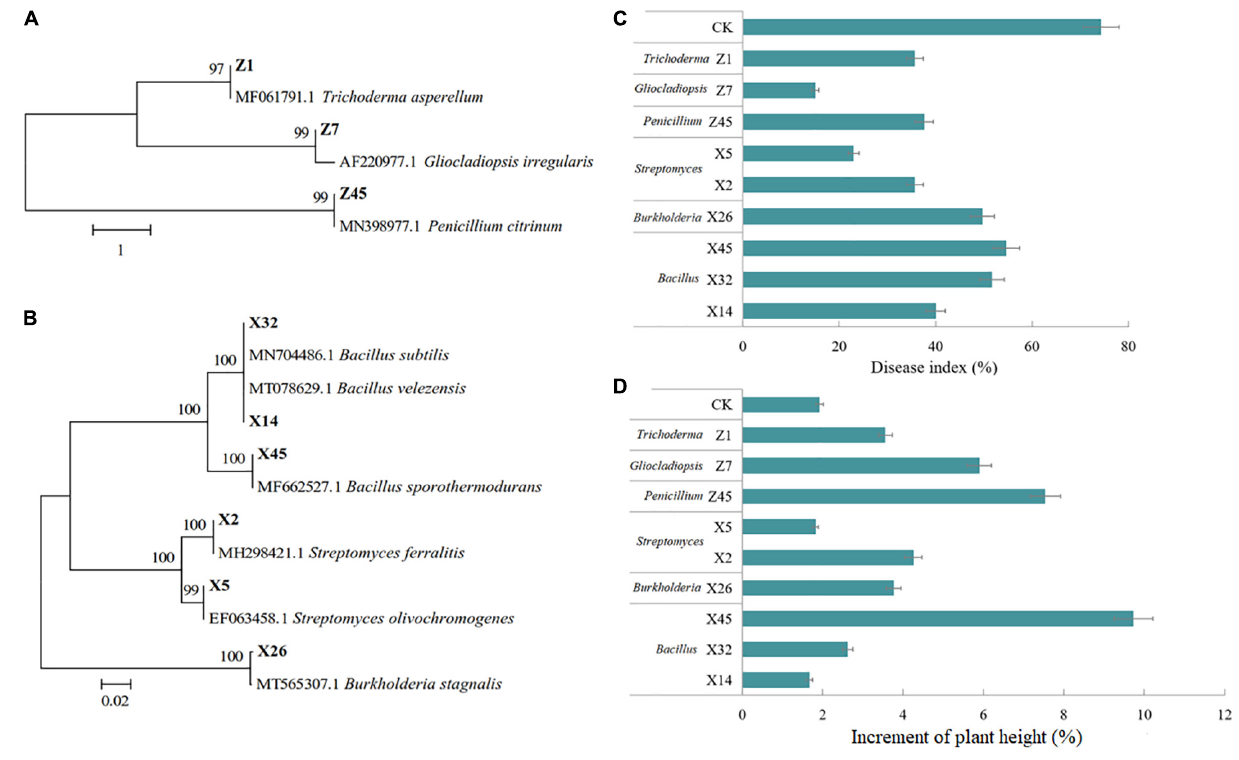
FIGURE 7 | Effect of beneficial fungi and bacteria on tea seedling growth and tea gray blight DI. Hierarchical clustering analysis of ITS genes of beneficial fungi (A) , and 16S rRNA genes of beneficial bacteria (B) . (C) DI of tea seedlings grown in soil inoculated with beneficial fungi or bacteria, and challenged by Ps. camelliae-sinensis for 7 days. (D) Plant height of tea seedlings grown in soil inoculated with beneficial fungi or bacteria for 30